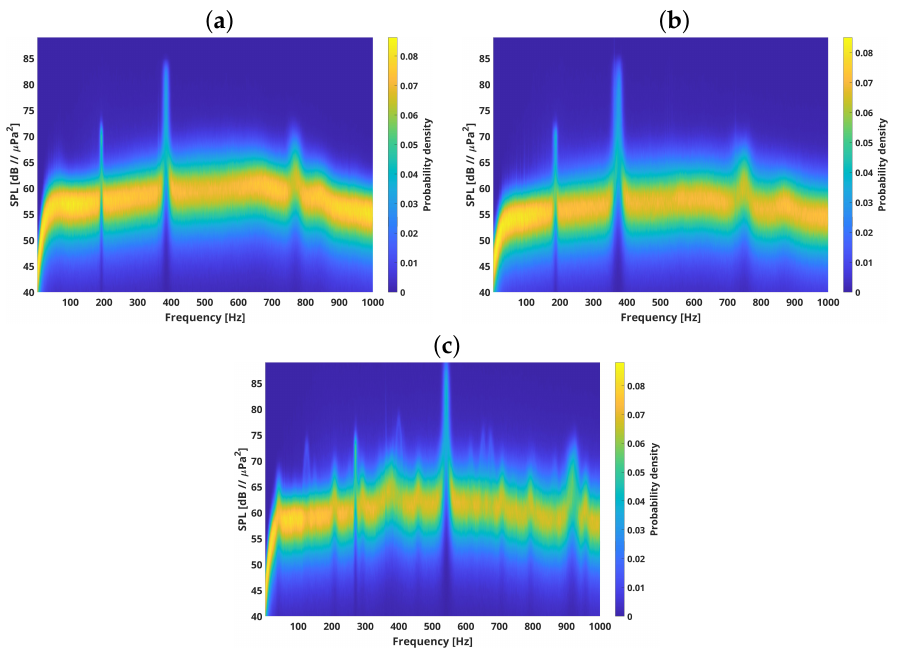
Figure 7. Spectral power distribution with 1 s, 50% overlap time slots between 14:00 and 20:00 UTC in June 2018 for recorders at sites CA ( a ), IN ( b ) and MG ( c